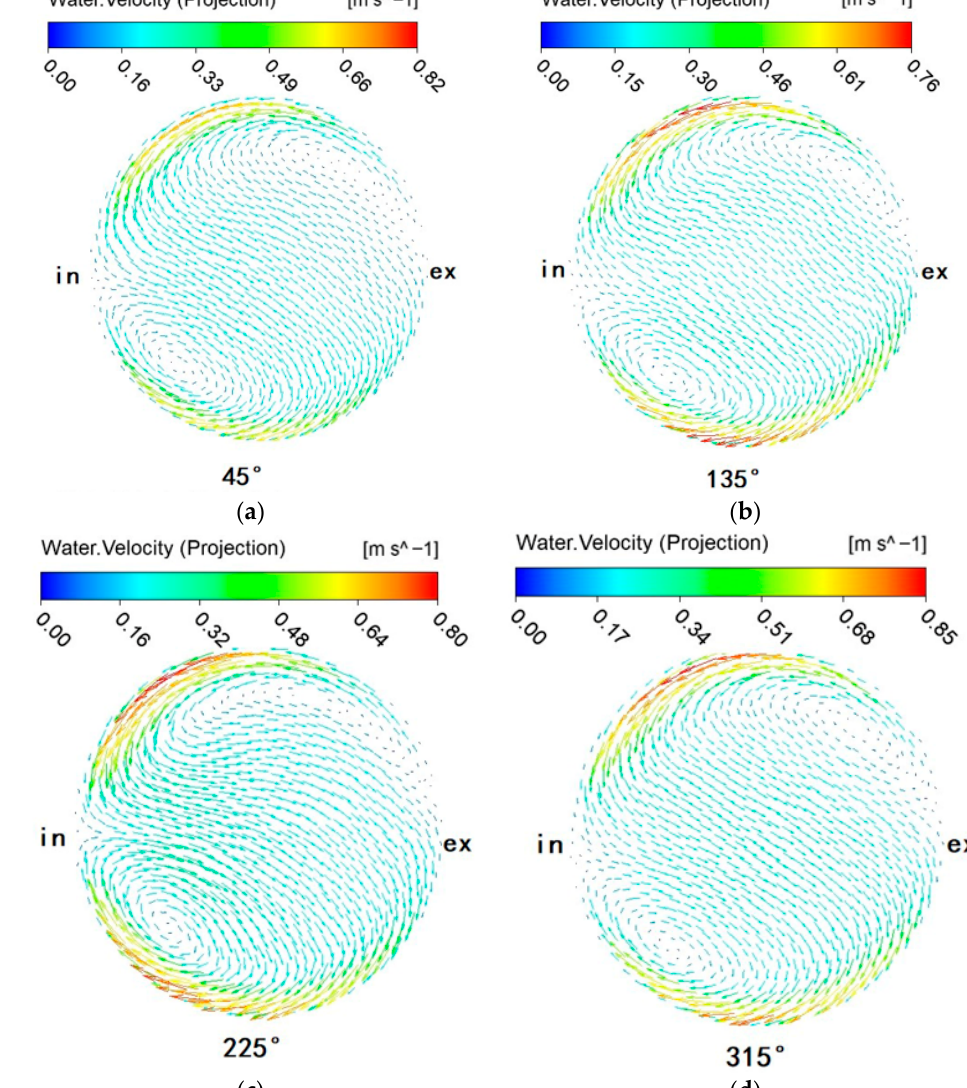
Figure 10. Radial velocity vector of liquid at cross-sections ( a – d ) ( v in = 10 m/s , α = 0.3 ). At the circumferential angles of 45 °, 135 °, 225 °, and 315 °, the maximum radial velocities are 0.82 m/s, 0.76 m/s, 0.80 m/s, and 0.85 m/s, respectively; the axial velocities are 9.7 m/s, 8.7 m/s, 8.9 m/s, and 9.5 m/s. Moreover, the maximum values of the secondary- flow velocity are 0.084, 0.087, 0.089, and 0.090 of the average axial velocities at cross-sec-